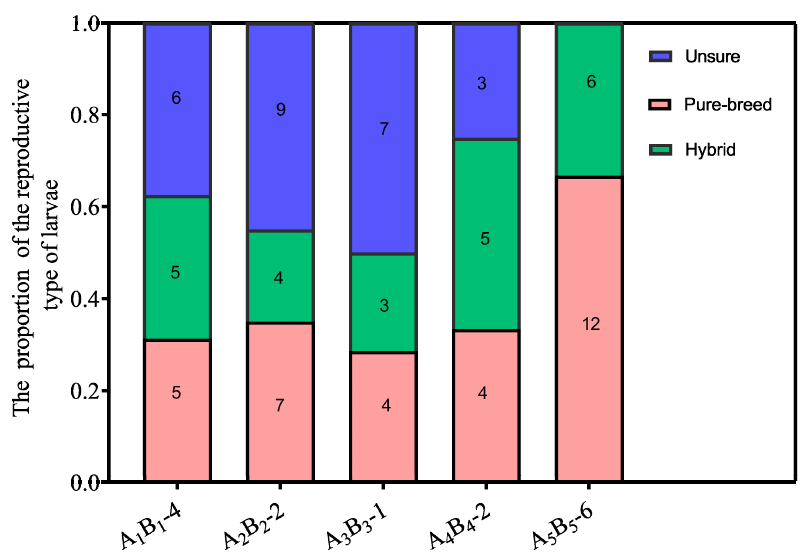
Figure 5. The proportion of larvae from the different mating types. The number in bar represent the number of larvae from this mating types in each colony.